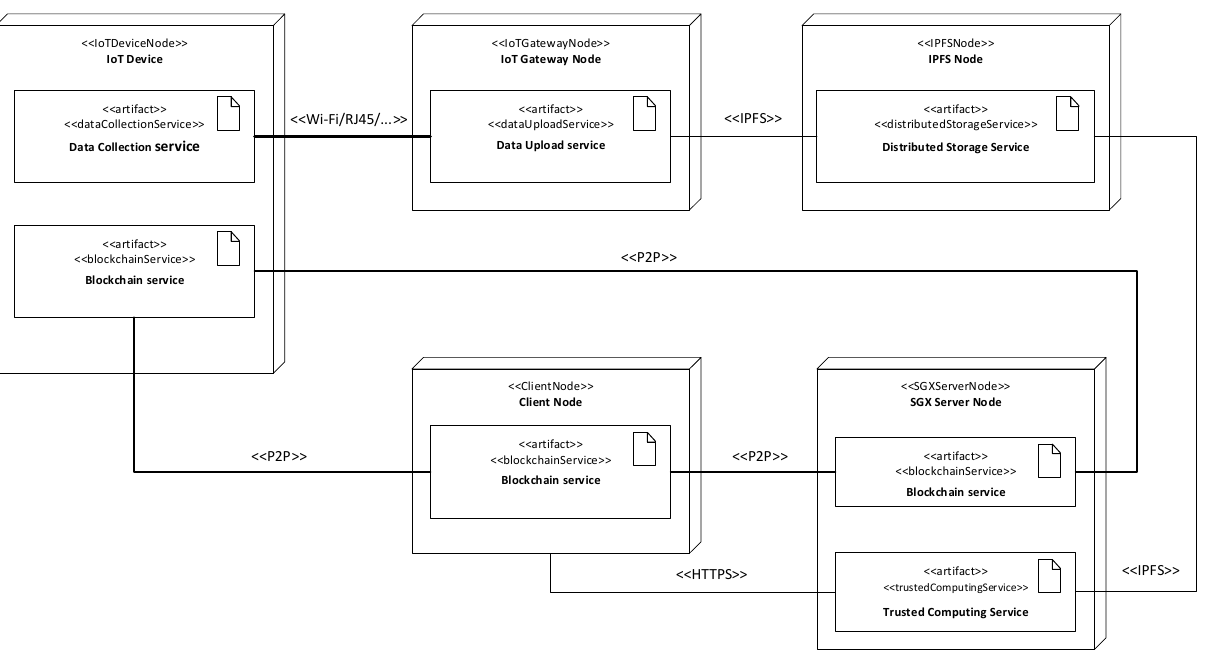
Figure 5. The UML deployment diagram of the system framework. Table 2. Stereotypes for nodes, services, and protocols.